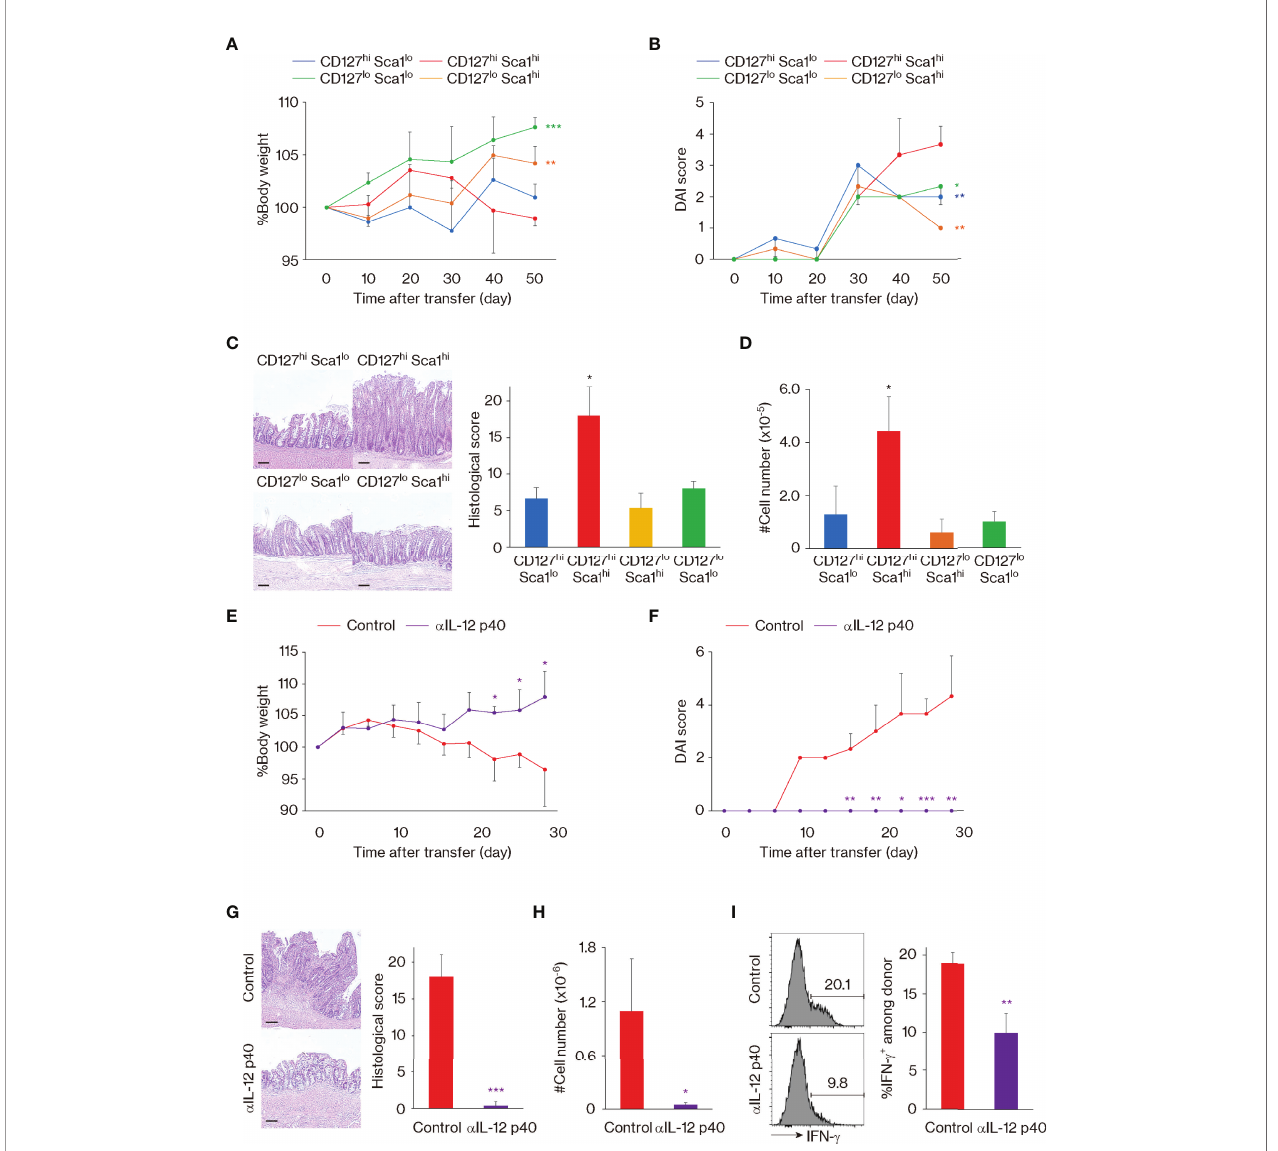
FIGURE 6 | The CD127 hi Sca1 hi memory-phenotype (MP) cell subset can induce colitis in Rag2 knockout (KO) mice. (A – D) Among the four MP subsets, CD127 hi Sca1 hi cells can induce the most severe colitis. Sorted MP subpopulations were individually transferred to Rag2 KO recipient mice. Graphs indicate (A) relative body weight (mean ± SD) and (B) disease activity index (DAI) score (mean ± SD) in each group at different time points as well as (C) histological score (mean ± SD) and (D) the number (mean ± SD) of donor cells in the colon on day 50 (n = 3 mice). Representative images showing histology of the colon from each group are also included in panel (C) . (E – I) Blockade of IL-12 p40 ameliorates MP-induced colitis. Sorted CD127 hi Sca1 hi MP cells were transferred to Rag2 KO mice that were then treated with anti-IL-12 p40 mAb or control IgG. Graphs show (E) relative body weight (mean ± SD) and (F) DAI score (mean ± SD) in each group at different time points as well as (G) histological score (mean ± SD), (H) the number (mean ± SD) of donor cells, and (I) their IFN- g + fraction (mean ± SD) in the colon on day 28 (n = 3 mice). Histological images of the colon from each group on day 28 are displayed in (G) . Data shown are representative of 2 independent experiments. Scale bars in histological images show 100 m m. Statistically signi fi cant differences are indicated as * p < 0.05, ** p < 0.01, and *** p <